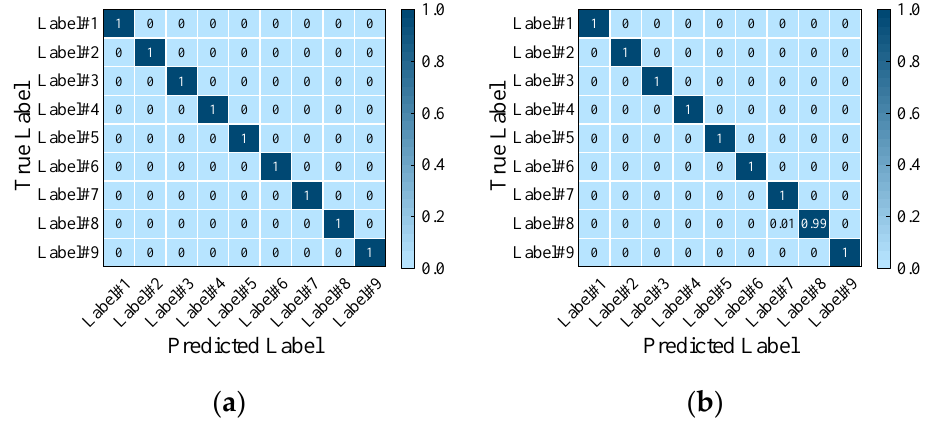
Figure 27. Confusion matrix: ( a ) source domain; ( b ) target domain.